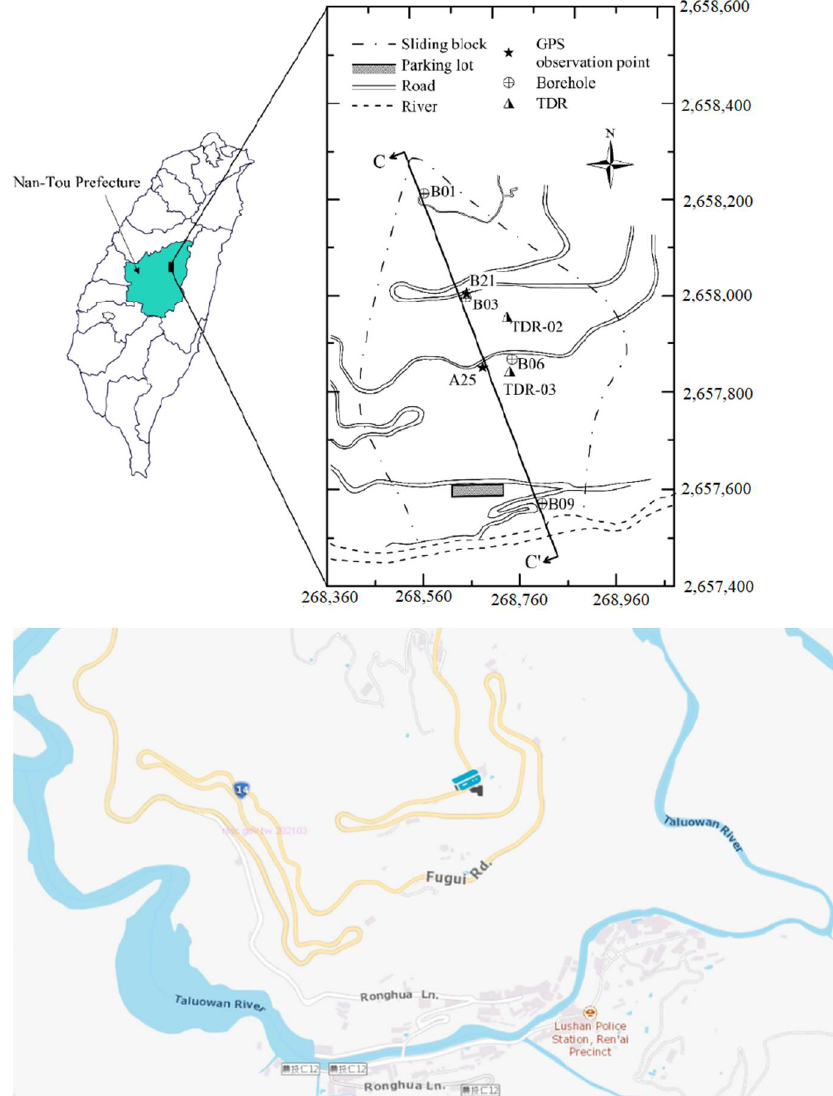
Figure 12. Locations and plan view of studied slope.